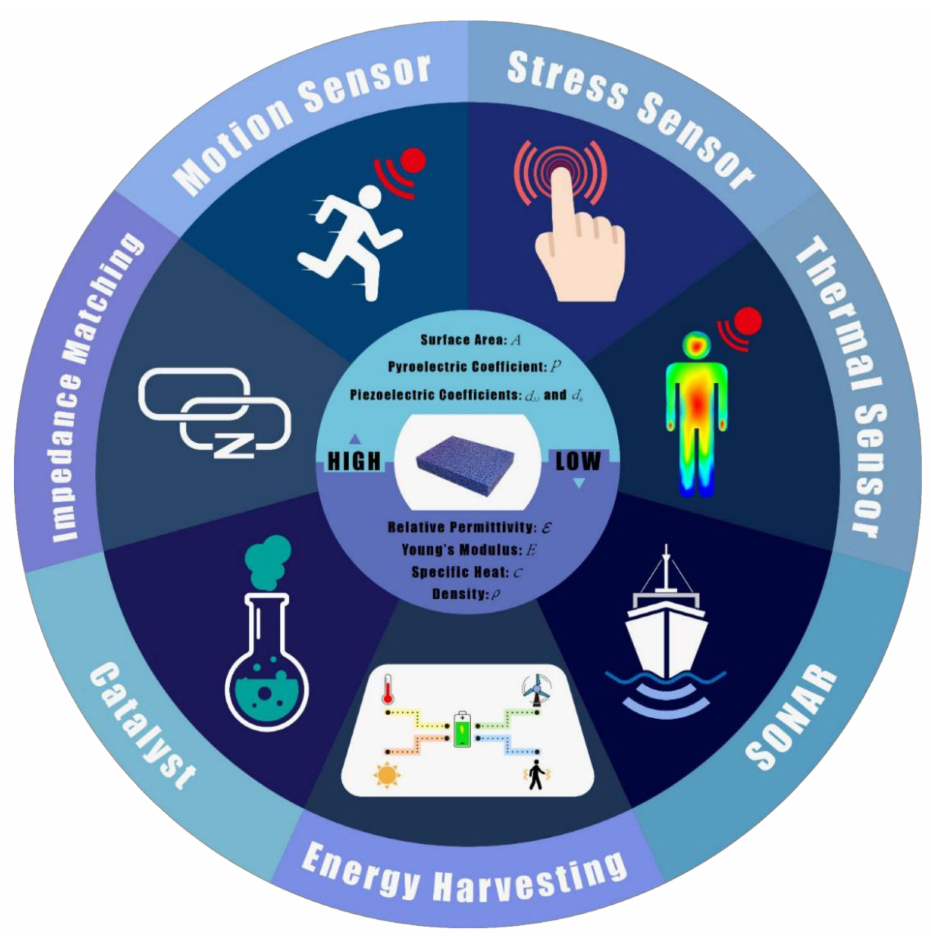
Figure 8. Benefits of porous ferroelectrics and their potential